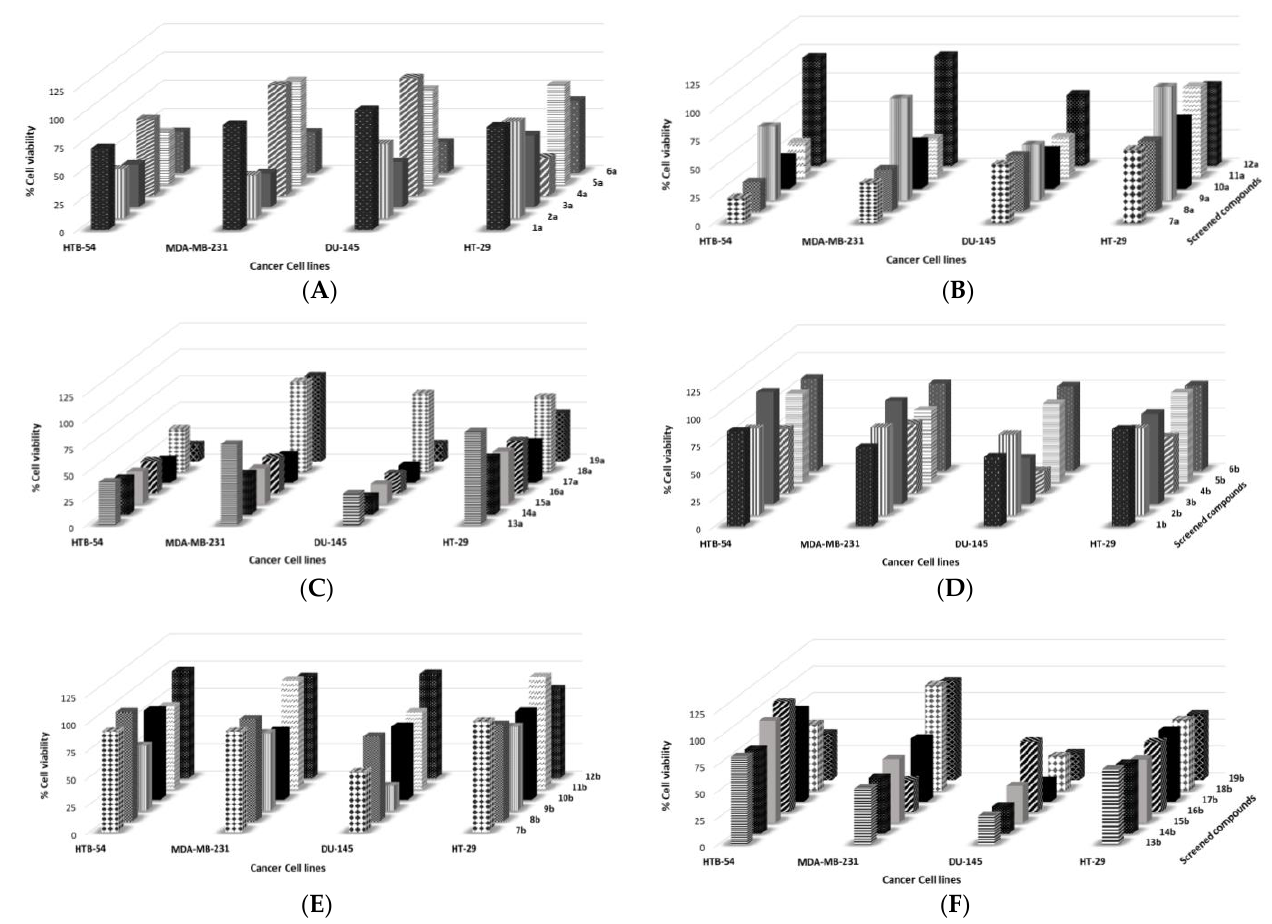
Figure 4. Antiproliferative effect of synthesized compounds 1a – 6a ( A ), 7a – 12a ( B ), 13a – 19a ( C ) from series a (allyl motif) and 1b – 6b ( D ), 7b – 12b ( E ), 13b – 19b ( F ) from series b (propargyl motif). Data correspond to at least three independent experiments.